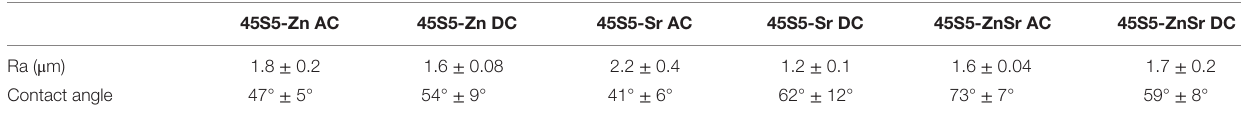
TaBle 3 | roughness (ra) and contact angle values of the different produced coatings.